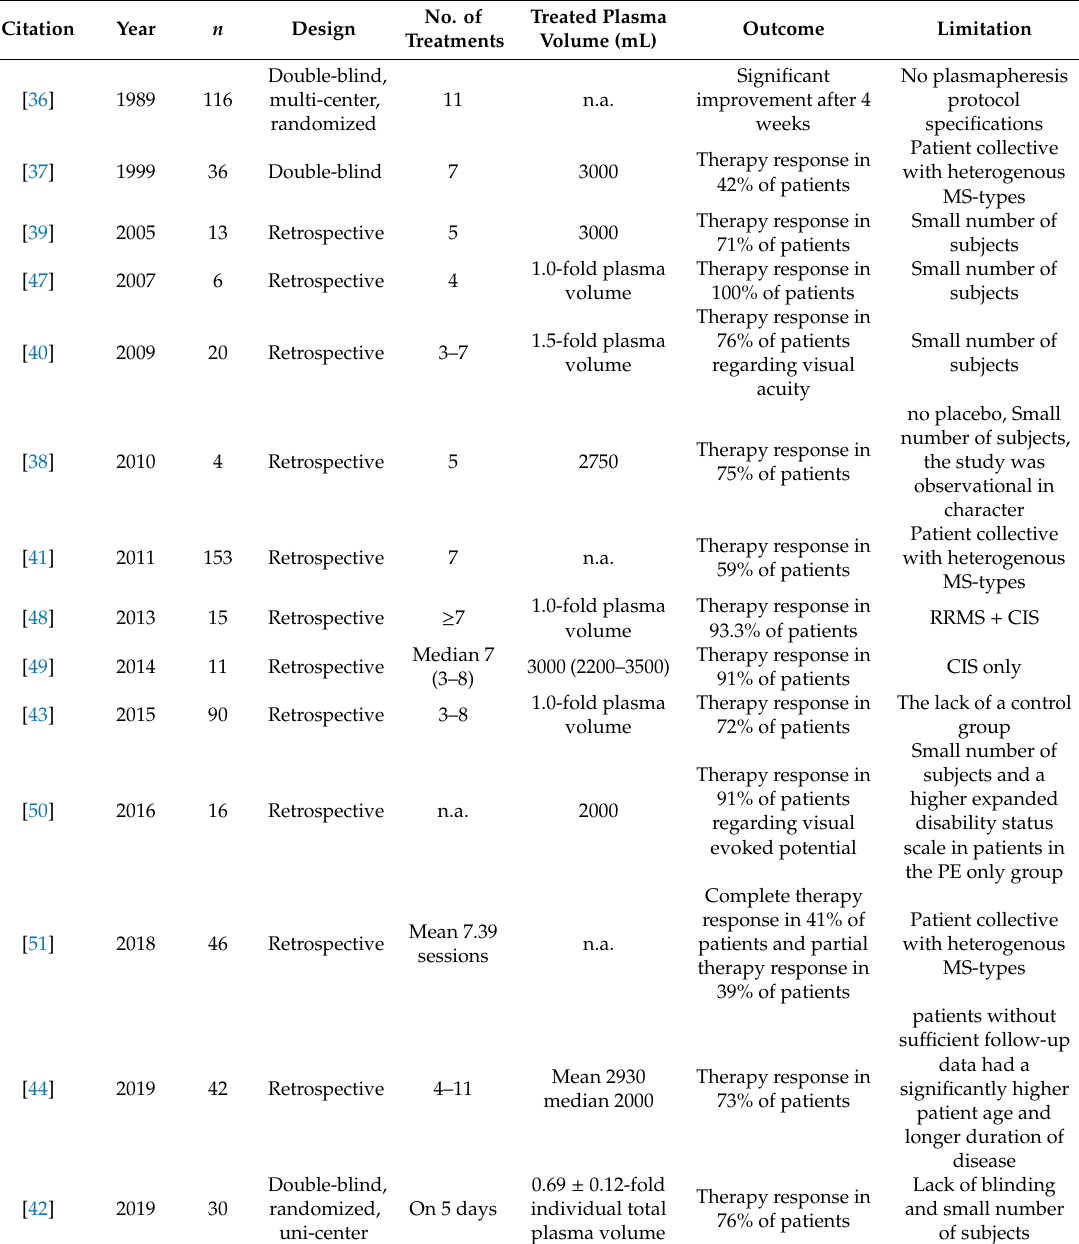
Table 1. Studies on plasma exchange (PE) in treatment of relapsing-remitting multiple sclerosis (RRMS), clinically isolated syndrome (CIS), progressive MS, isolated optic neuritis, and neuromyelitis optica (NMO). EDSS = Expanded Disability Status